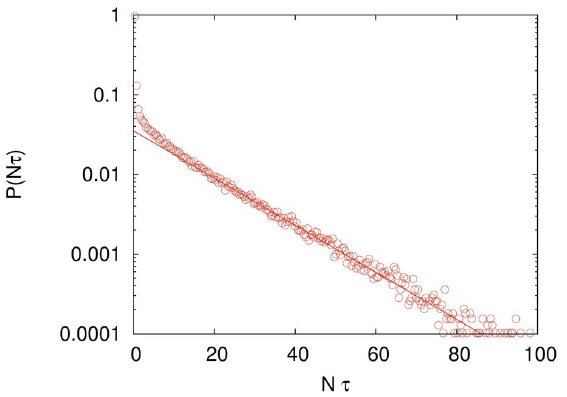
Figure 4. The effect of group size on the computational cost of the fully connected system. The symbols represent the mean rescaled computational cost S N t T for the imitation probability p ~ 0 (magenta circles), p ~ 0 : 3 (red diamonds), p ~ 0 : 4 (green squares), p ~ 0 : 5 (blue inverted triangles) and p ~ 0 : 6 (cyan triangles). The independent variable N is the number of agents in the system. The influence network size is M ~ N { 1 . Each symbol represents an average over 10 5 searches and the lines are guides to the eye. The error bars are smaller than the size of the symbols.